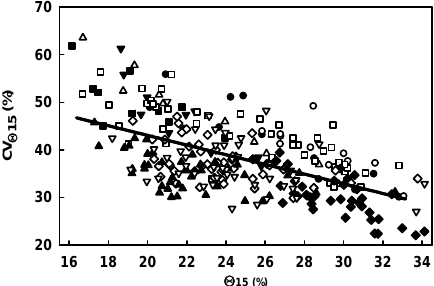
Fig. 2. Association between growing season mean volumetric soil water content for 0–15cm ( 2 15 ) and its coefficient of variation (CV 2 ). Each point represents a plot, and symbols denote dif- 15 ferent years.